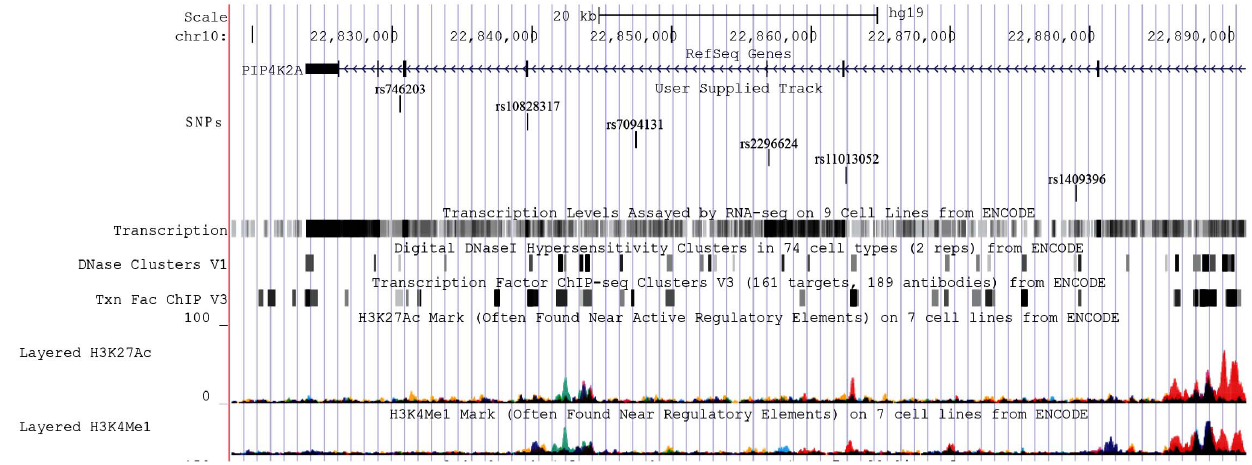
Figure 3. Identification of regulatory potential of six marker haplotype using ENCODE data from UCSC genome browser.